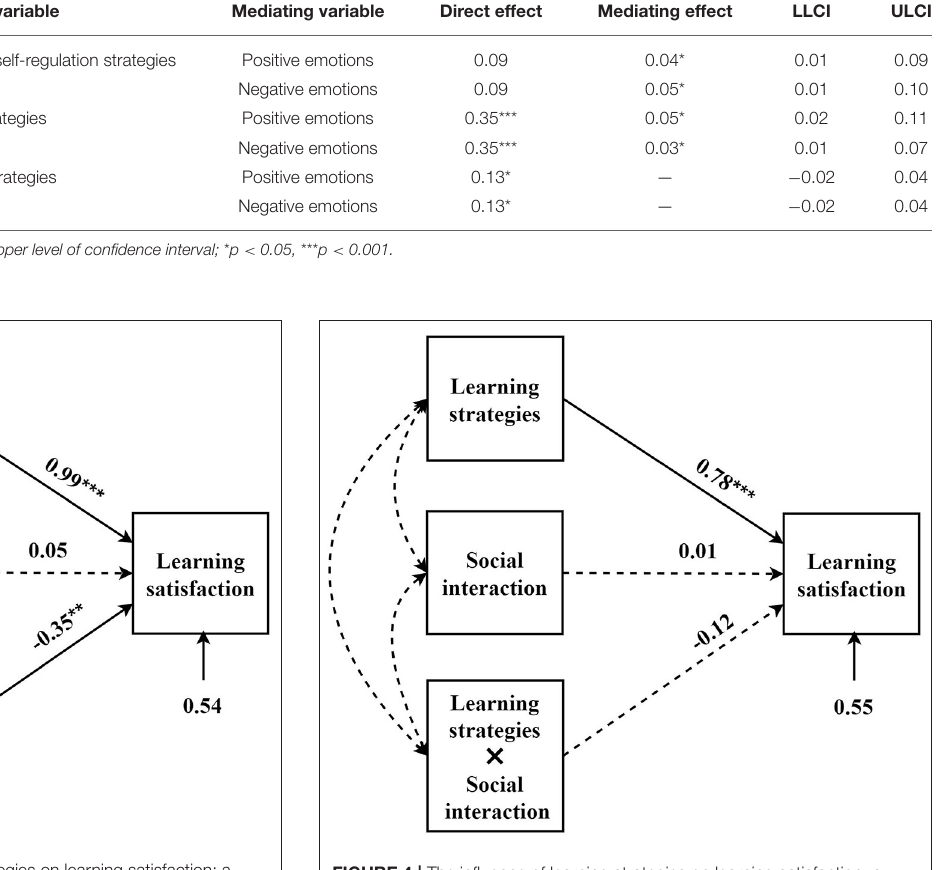
lower dropout rates (Hew et al., 2020), and better